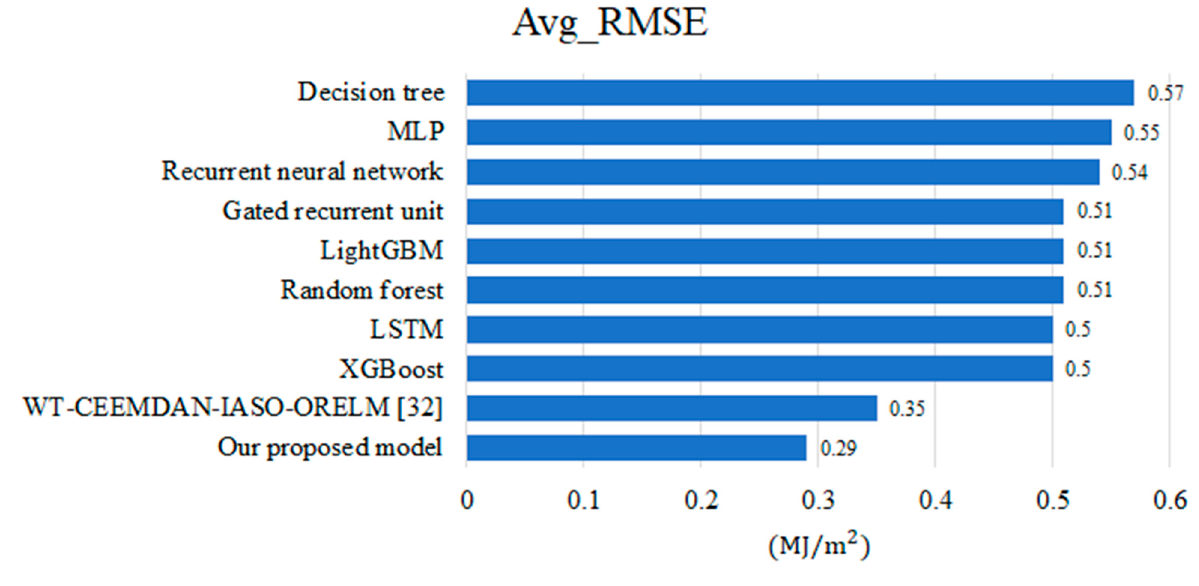
Figure 9. Average RMSE comparison of solar radiation forecasting models (MJ/m 2